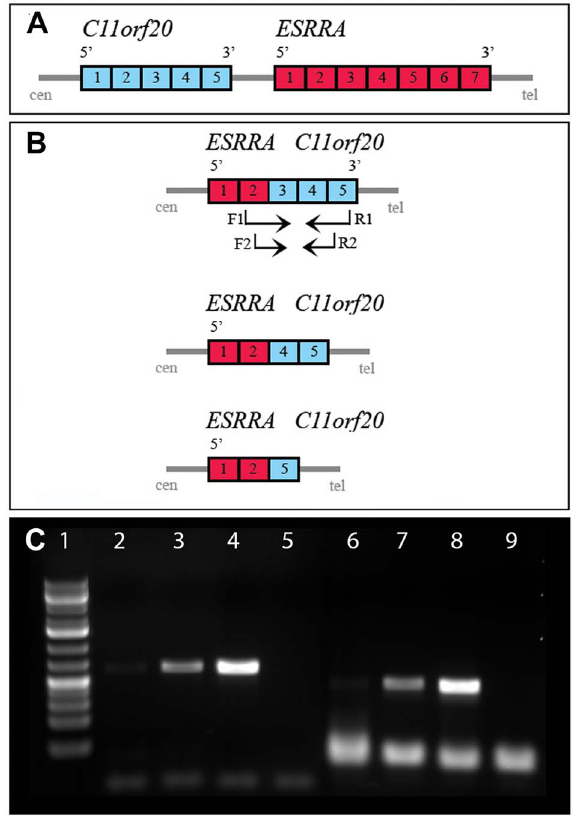
Figure 1. Putative ESRRA-C11orf20 fusion transcript in ovarian carcinomas. (A) Schematic orientation of the ESRRA and C11orf20 genes in the genome (the size of each exon is not in scale). (B) Representation of the three forms of the putative fusion with involvement of ESRRA exon 2 with C11orf20 exon 3, 4, or 5. Arrows indicate position of the primers for the first PCR (F1 and R1) and the NESTED PCR (F2 and R2). Primer details are given in Materials and Methods. (C) Image of the gel electrophoresis for the synthetic transcript containing the fusion (internal positive control). A plasmid containing exon 2 of ESRRA and exon 5 of C11orf20 was used as a positive control for our PCR experiments. Three different concentrations of the plasmid were tested using the ESRRA and C11orf20 PCR primers. Lane 1, 1 kb DNA ladder; lanes 2 and 6, 2 fg plasmid ( , 30 copies of the plasmid); lanes 3 and 7, 20 fg plasmid ( , 300 copies of the plasmid); lane 4 and 8, 200 fg plasmid ( , 3,000 copies of the plasmid). Lanes 2–5, primers G1P1-FWD ( ESRRA ) and REV_pair3 ( C11orf20 ) used; lanes 6–9, inner (nested) primers G1P2-FWD ( ESRRA ) and F1-REV ( C11orf20 ) used. Lanes 5 and 9 are negative controls with no plasmid template.